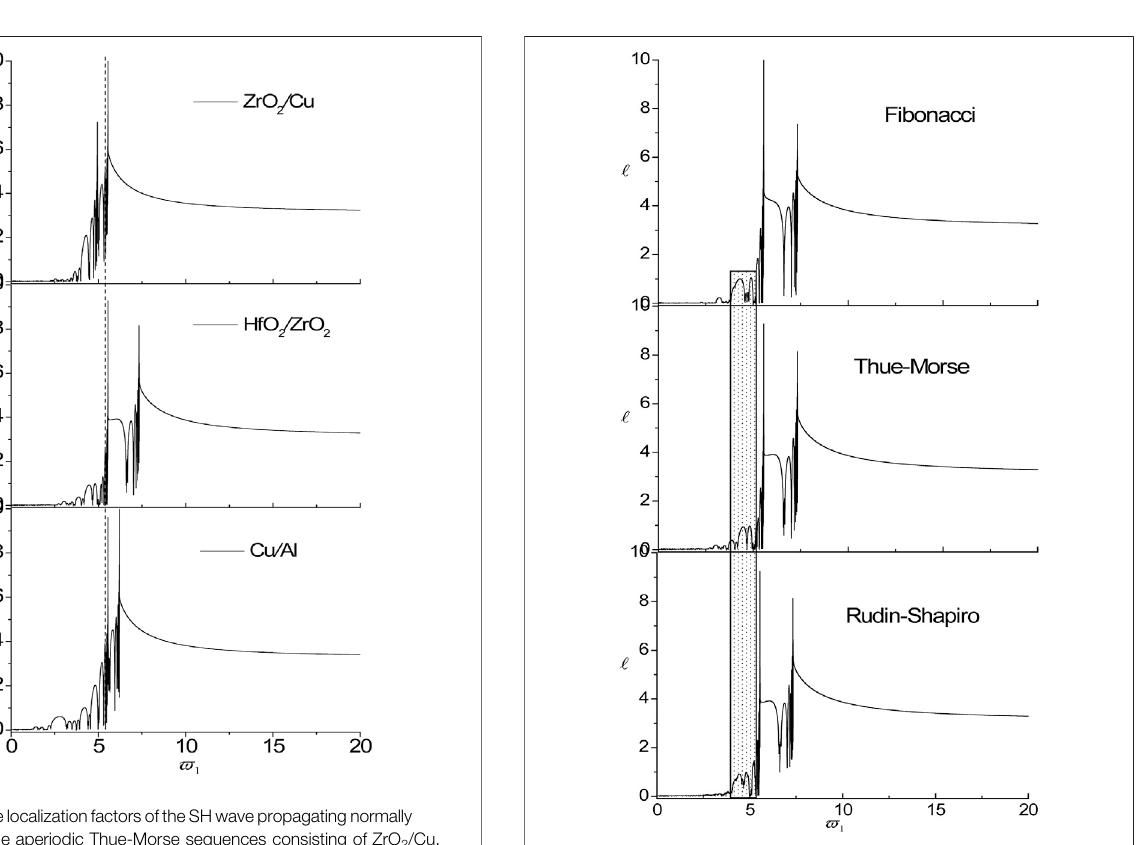
FIGURE 7 | The in fl uences of aperiodic arrangements on localization factors of the SH wave propagating normally in the nanoscale aperiodic systems consisting of HfO 2 /ZrO 2 for τ 1 = τ 2 =